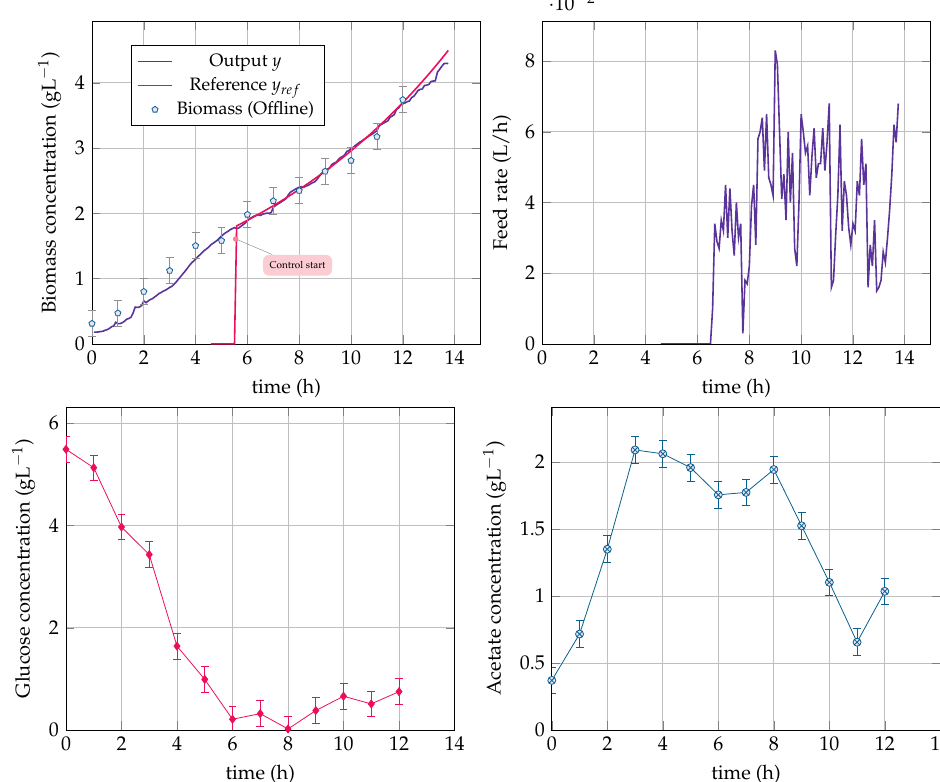
Figure 15. Experiment 2: Time evolution of the measured biomass, reference profile, glucose, acetate concentrations, and feed